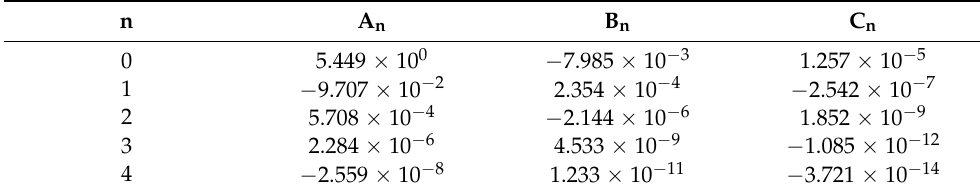
Table A10. Coefficients of the H 2 O-LiBr + LiNO 3 specific heat